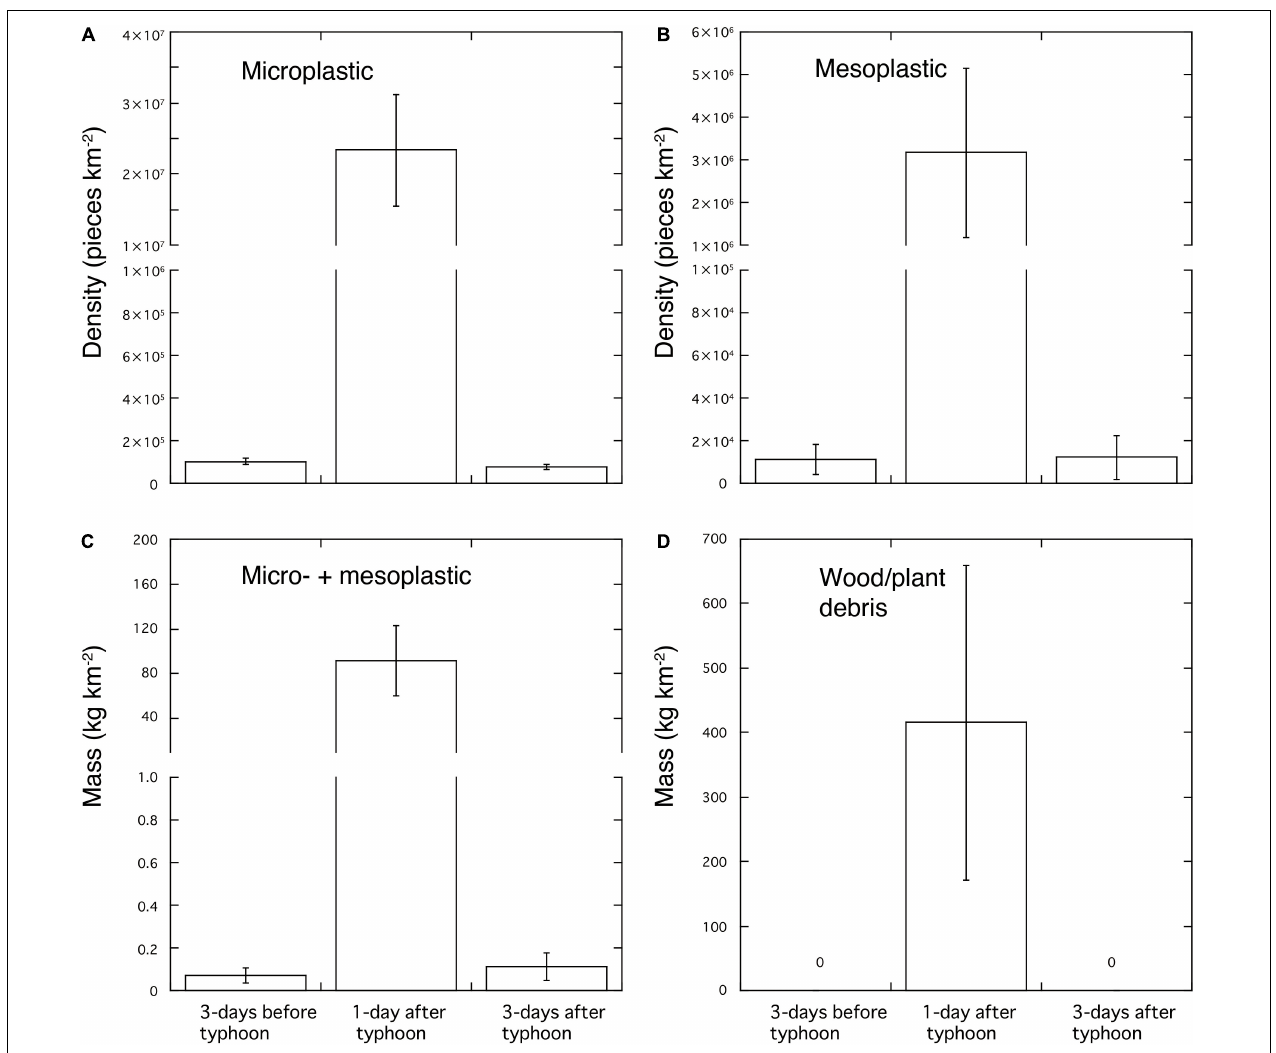
FIGURE 2 | Changes in the density and mass of plastic and other debris 3-days before, and 1- and 3-days after typhoon passage: density (pieces km − 2 ) of (A) microplastic and (B) mesoplastics, and mass (kg km − 2 ) of (C) micro − + mesoplastics and (D) wood and plant debris. Error bars indicate standard deviation of mean.